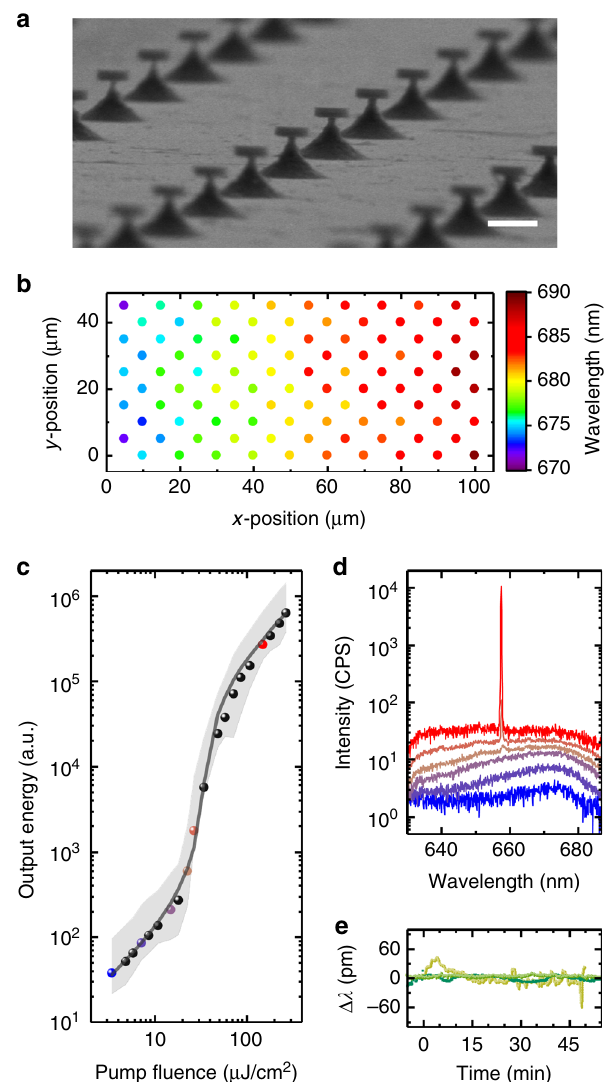
Fig. 2 Nanodisk laser characterization. a Scanning electron microscopy image of an array of as fabricated nanodisks on struts. Scale bar, 1 µ m. b Color map illustrating the lasing wavelengths for a region of 100 nanodisks on the sample from ( a ), showing an increase in wavelength with increasing disk diameter. c Log-log plot of light intensity emitted by detached nanodisk lasers in cell medium as a function of pump intensity. Average threshold curve for N = 10 nanodisks (symbols), min/max output energy band of same disks (gray band) and fi t to the average with rate- equation model (gray line). d Emission spectra for a representative nanodisk at pump fl uences corresponding with the colored symbols in ( c ). e , Spectral stability of lasing peak for three typical detached nanodisks in cell medium under continuous excitation at 100 Hz; intensity of pump pulses, 100 µ J cm −